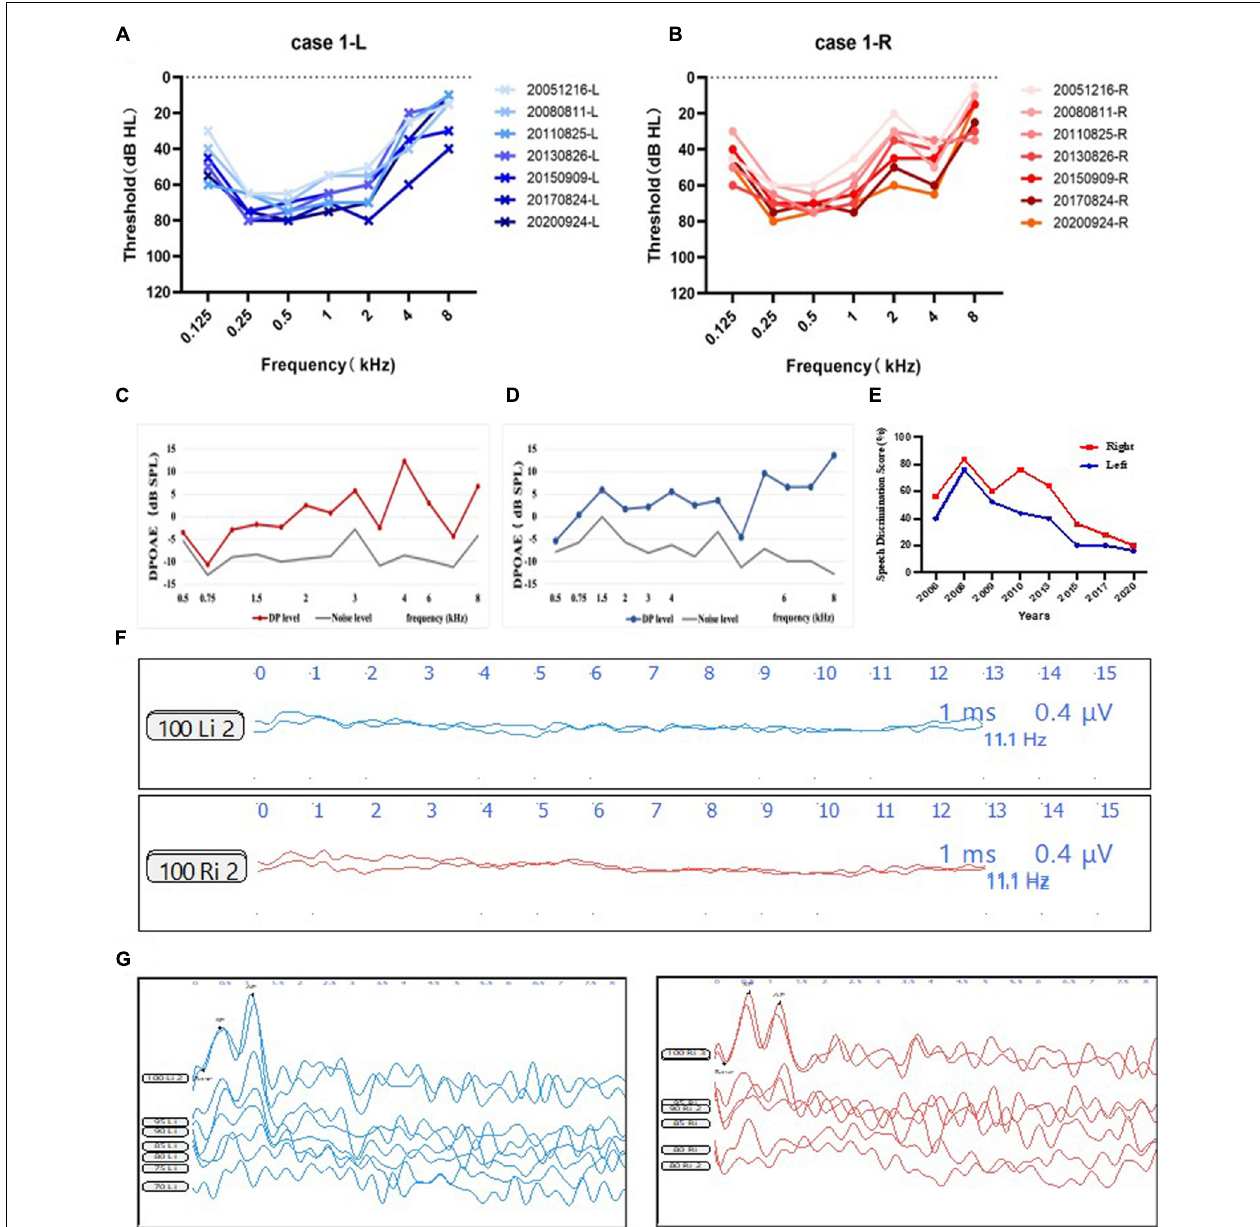
FIGURE 1 | Audiological phenotype of subject 1. (A,B) PTA of the subject 1. Audiograms of patient 1 from 2005 to 2020 displaying moderate to severe sensorineural hearing loss, predominantly affecting the low frequencies and progressively deteriorated overtime. Blue, left ear; red, right ear. (C,D) Observed DPOAE responses from the right and the left ear. Red line, DPOAE level from the right ear; blue line, DPOAE level from the left ear; gray line, noise level. (E) SDS results from 2006 to 2020 showing decreased speech discrimination score. Blue, left ear; red, right ear. (F) Absent ABR waveforms at 90 dB nHL stimulus on both